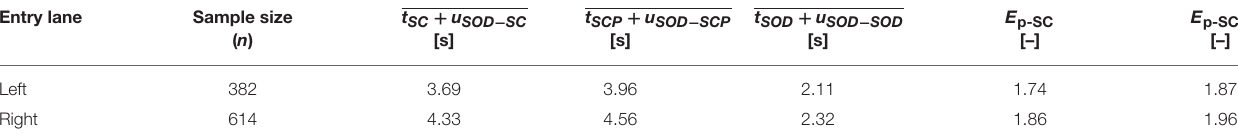
TABLE 7 | The passenger car equivalent factors for the time gaps between vehicles moving on the circulatory roadways of turbo roundabouts.